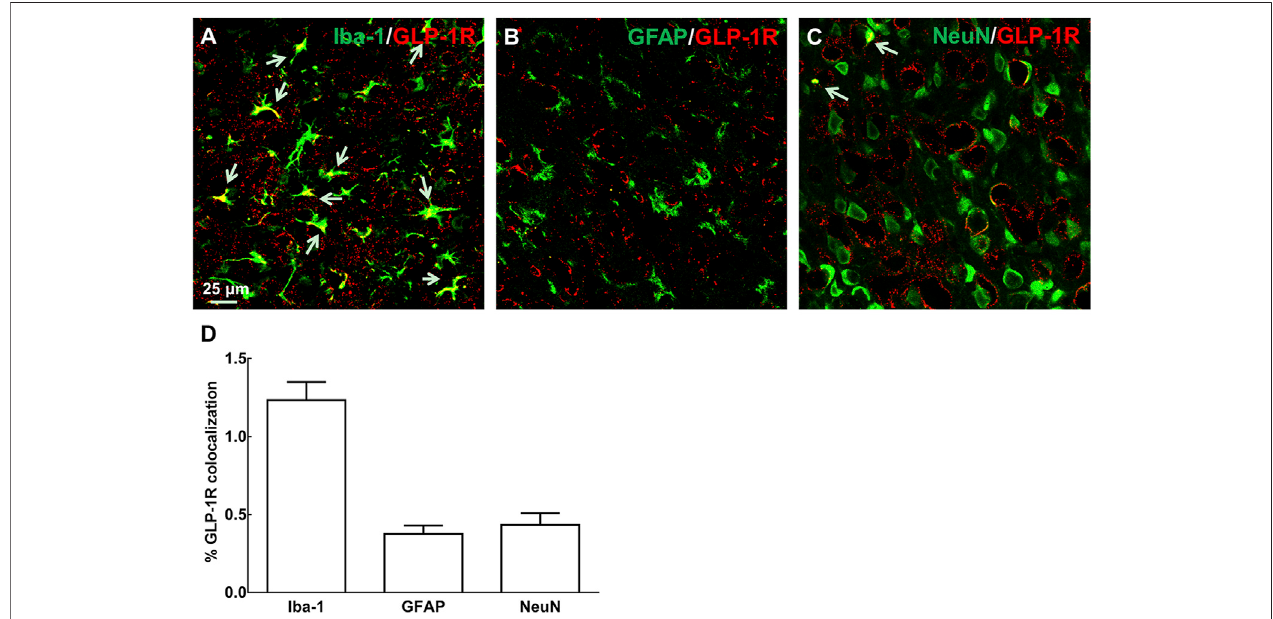
FIGURE 1 | Immunological co-localization of GLP-1R with each cytological marker [ (A – C) : anti-GFAP for astrocytes, anti-Iba-1 for microglia, and anti-NeuN for neurons, n (cid:2) 4] on day 3 after ischemic onset in MCAO-induced mouse. It indicated that GLP-1R was mainly expressed in microglial cells with a small amount of fl uorescentsignalinneurons. (D) Fluorescentco-localizationofGLP-1Rwitheachcytologicalmarkerwasquantitativelyanalyzedintherepresentativephotomicrographs of cortical peri-infarct area in ischemia/reperfusion-induced mice at × 40 magni fi cation (scale bar: 25 μ m).